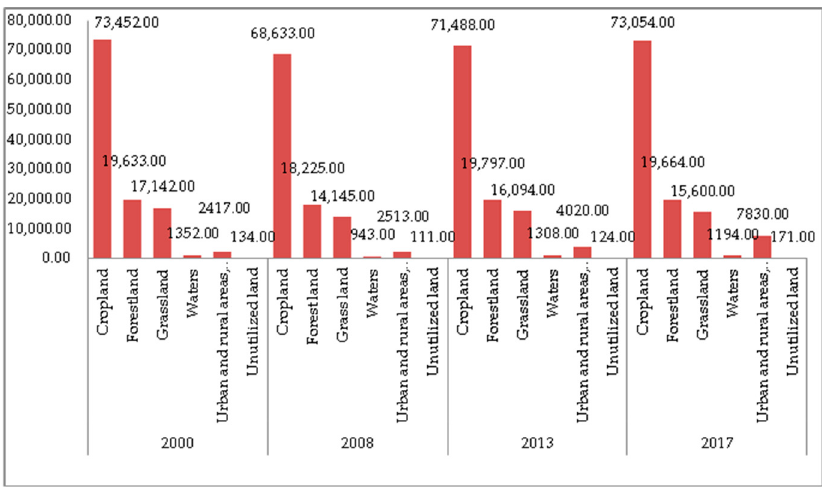
Figure 4. The Patch Number (NP) changes of various types of landscapes.